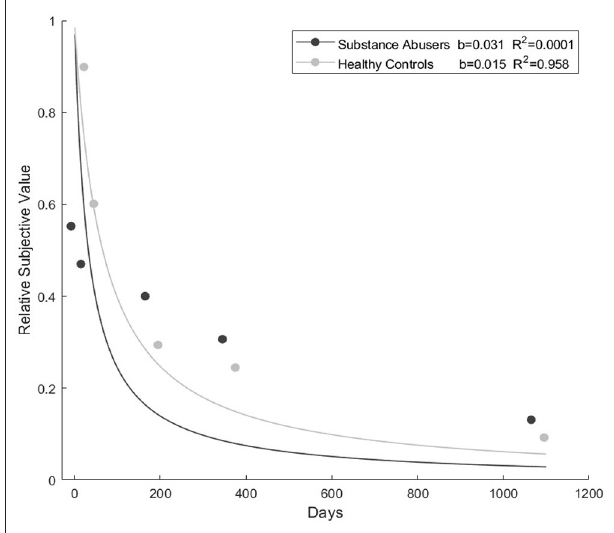
FIGURE 1 | Discounting curve and fit to hyperboloid